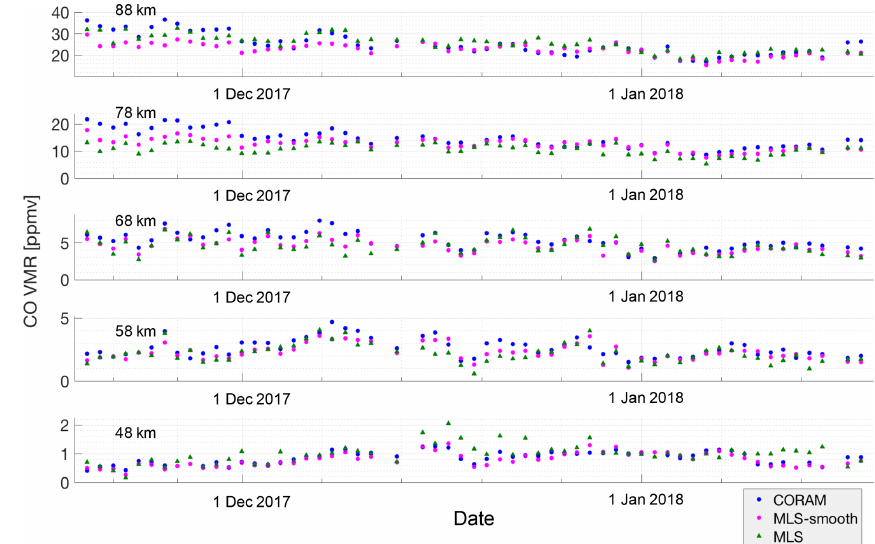
Figure 7. Time series of the daily CORAM and MLS CO VMR values at altitudes of 48, 58, 68, 78, and 88km.